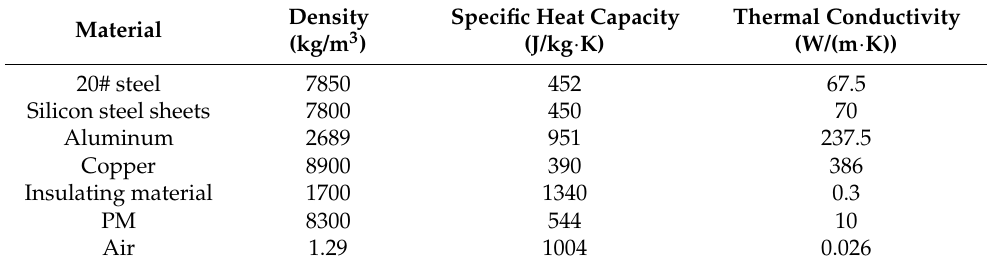
Table 2. Material parameters of DHEG